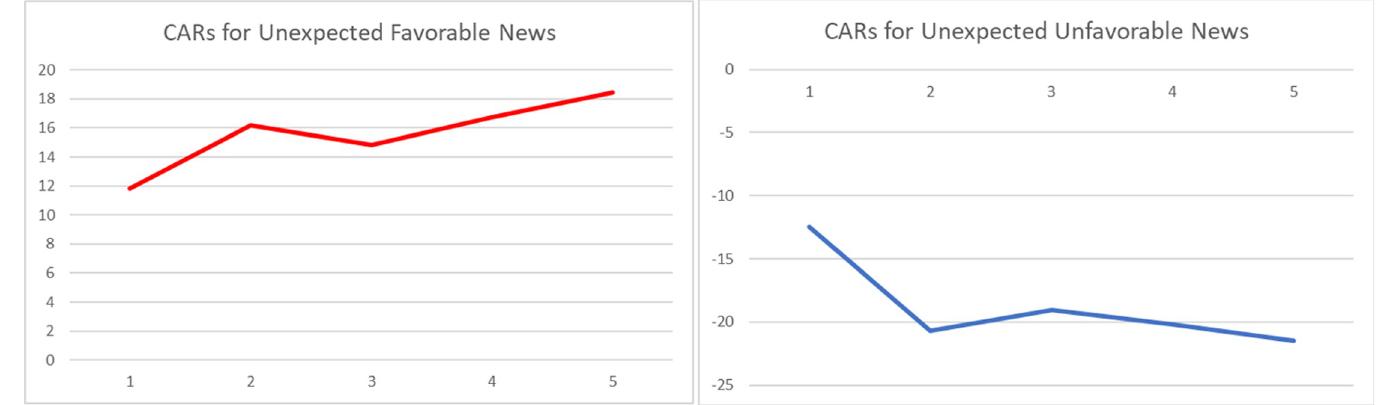
Fig 2. Graphs of daily CARs during a 5-day window following arrival of unexpected event (first period– 1.01.2011 to 31.12.2013).